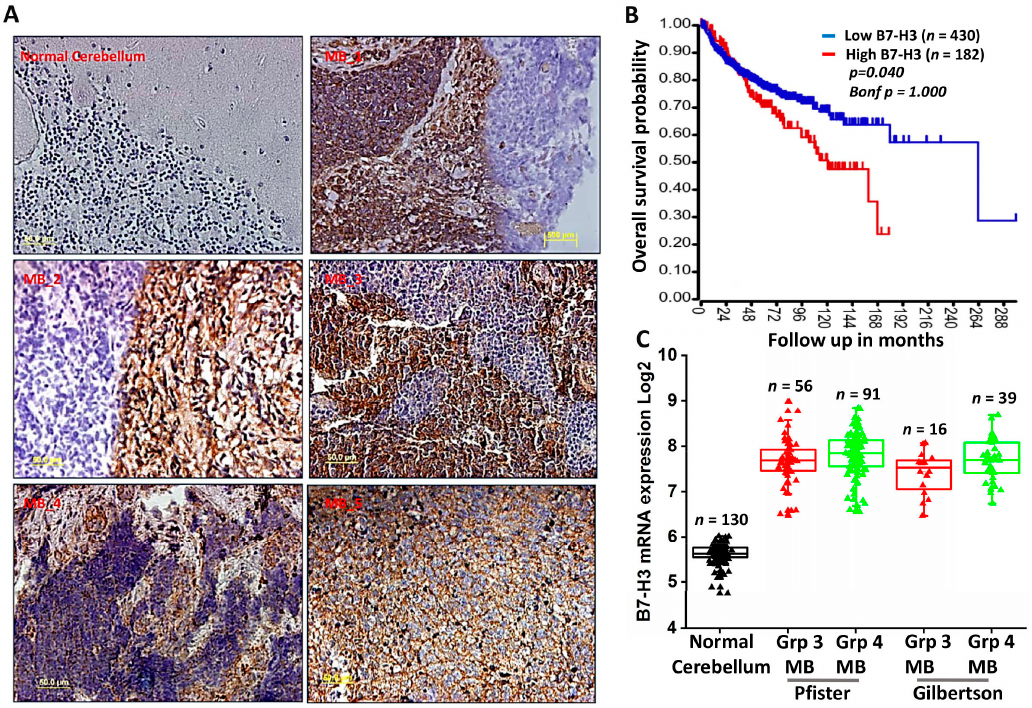
Figure 1. B7-H3 is elevated in MB patient samples and is associated with poorer survival. ( A ) Immunostained MB patient tissue samples compared to normal cerebellum against B7-H3 ( brown ) with nuclear staining ( blue ). B7-H3 expression detected in 5 MB tissue samples but not in normal cerebellum. ( B ) Kaplan-Meier survival plot showing overall survival probability of MB samples with high ( red ) or low ( blue ) B7-H3 mRNA expression in months ( p = 0.040). Transcript data obtained from Cavalli dataset and analyzed by log rank test. ( C ) Box plots of B7-H3 mRNA levels across 2 MB subgroups from Northcott dataset plotted on Log2 scale.